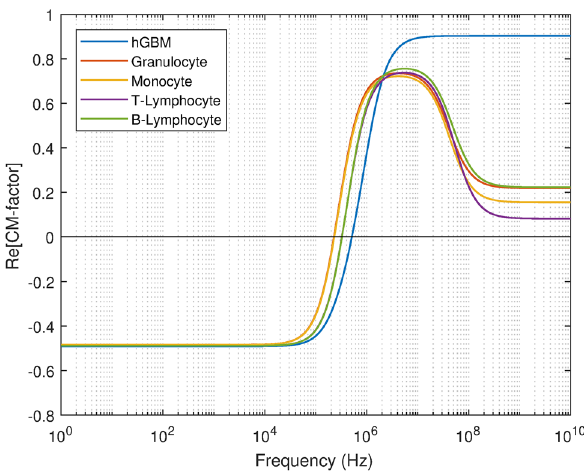
Figure 2. Real part of Claussius–Mossotti (CM) factor of hGBM and subtypes of leukocytes is mapped against applied frequency using single shell